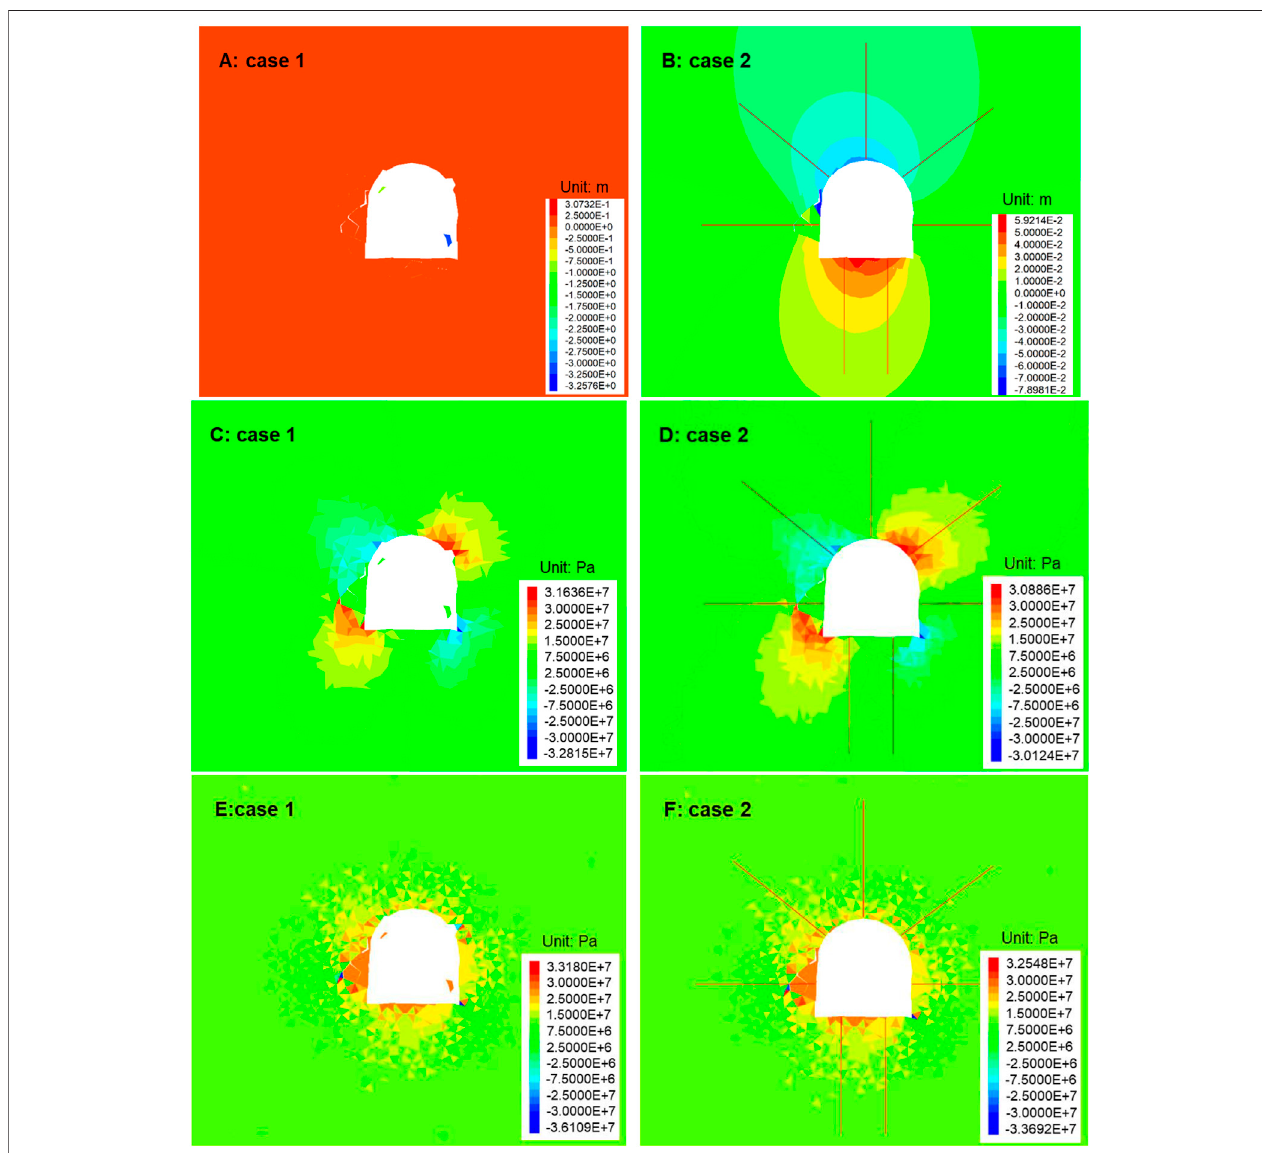
FIGURE 11 | Numerical simulation results of case 1 and case 2. (A,B) Y-displacement distribution. (C,D) Shear stress distribution. (E,F) The maximum principal stress distribution.